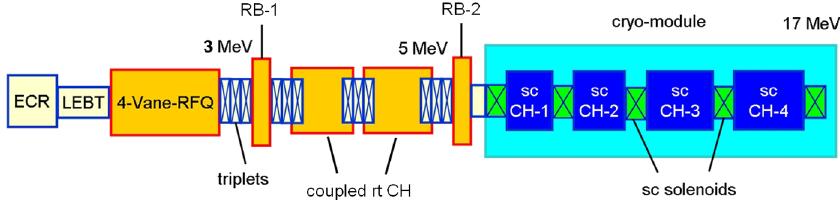
FIG. 3. (Color) The schematic diagram of the proposed layout for the EUROTRANS